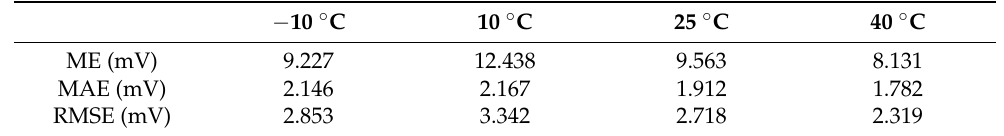
Table 4. The terminal voltage error statistical